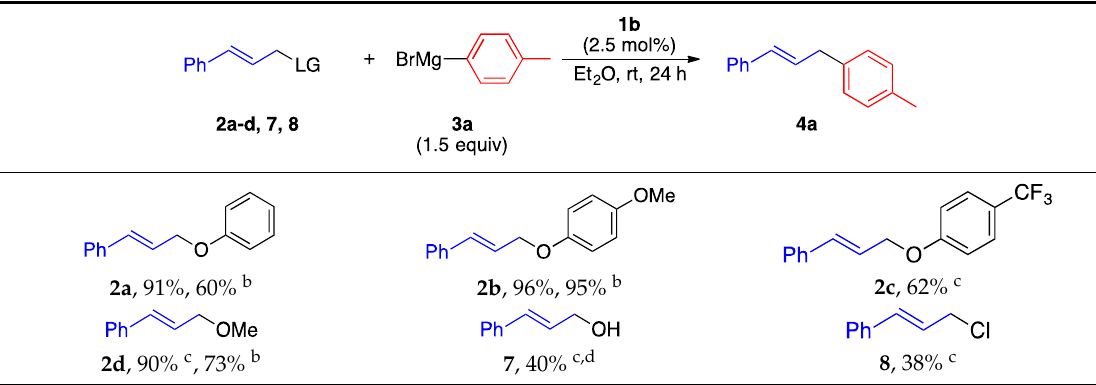
Table 3. The effect of the leaving group (LG) on the cinnamyl electrophiles. a